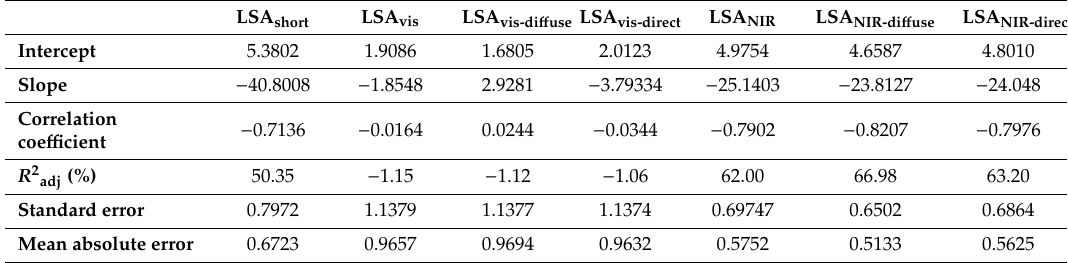
Table 2. The linear regression models between the field-measured CBI values and the immediately post-fire LSA images (CBI = a × LSA + b).